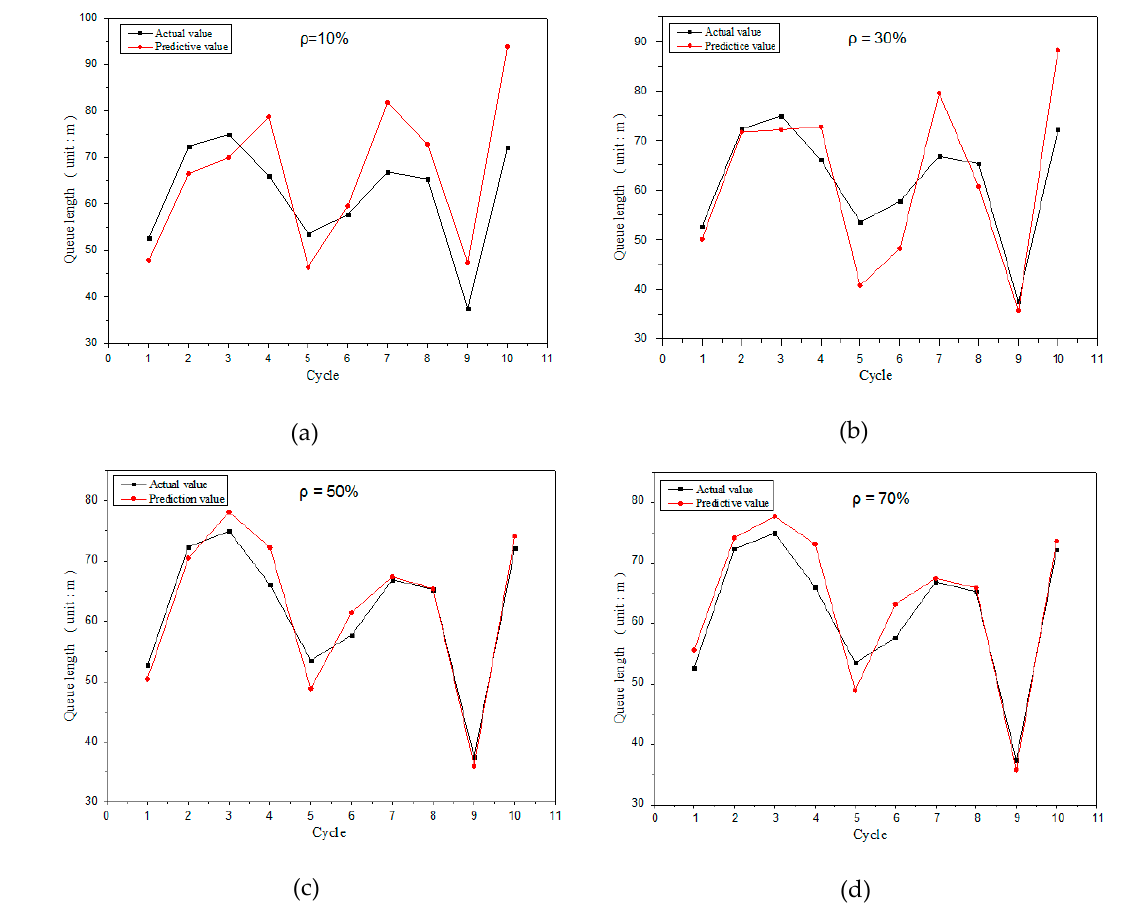
Figure 8. Queue length at 10% penetration rate (a) and queue length at 30% penetration rate (b) and queue length at 50% penetration rate (c) and queue length at 70% penetration rate (d) .